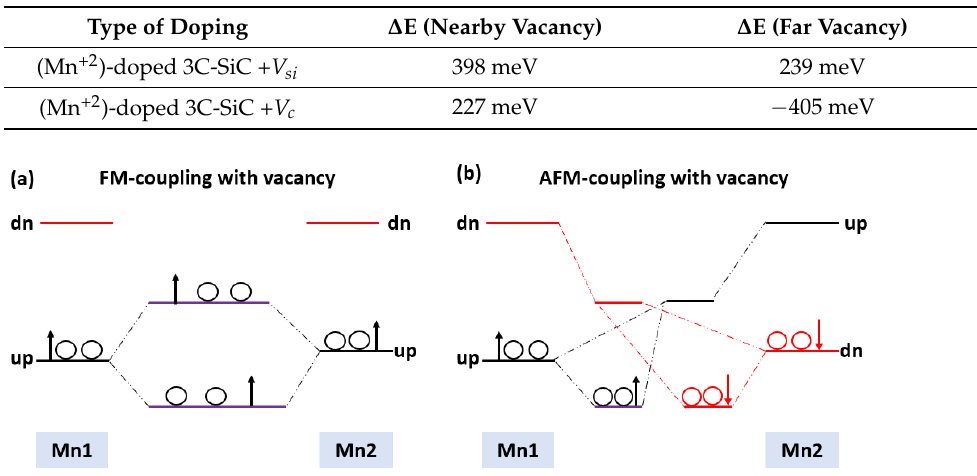
Figure 10. Schematic energy levels for two interaction Mn- 3d with their spin ( a ) FM vacancy ( b ) AFM vacancy.